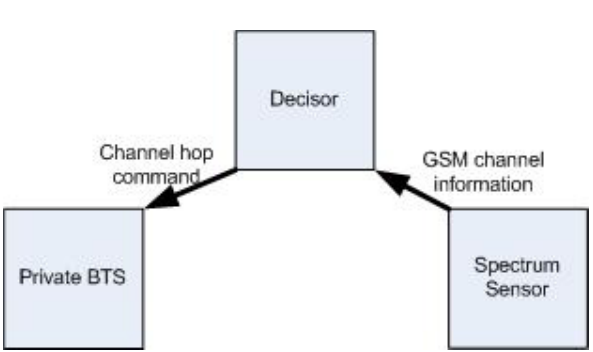
Figure 2. Cognitive BTS